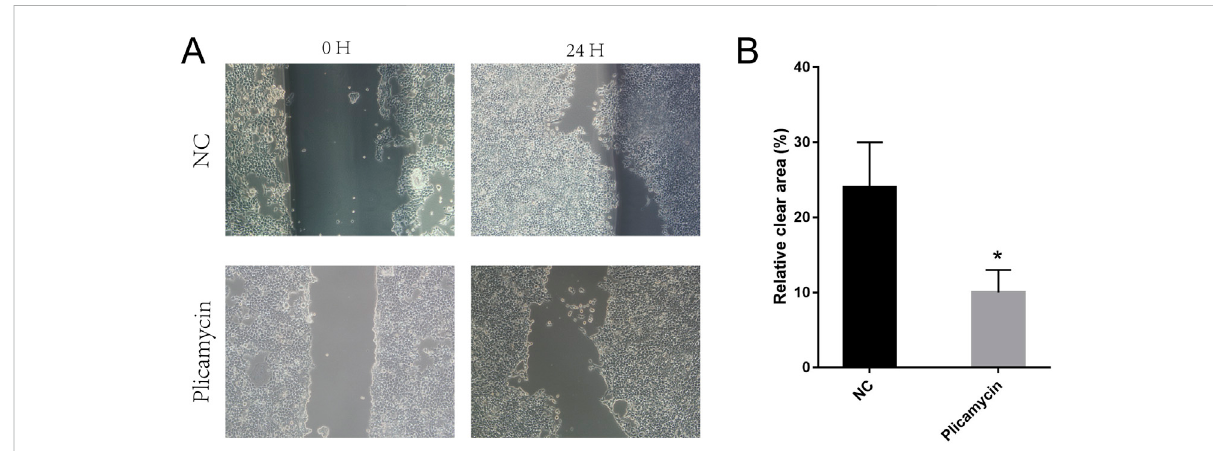
FIGURE 10 Pplicamycin treatment reduced the mobility of TU212 cells. (A) Wound-healing assay for migration activity of untreated (upper panel) and treated (lower panel) TU212 cells. After 24 h, we captured representative images of the migrating cells. (B) Quantitative analysis of untreated TU212 invasion effects compared to treated TU212 invasion effects. Invasive cells were counted on